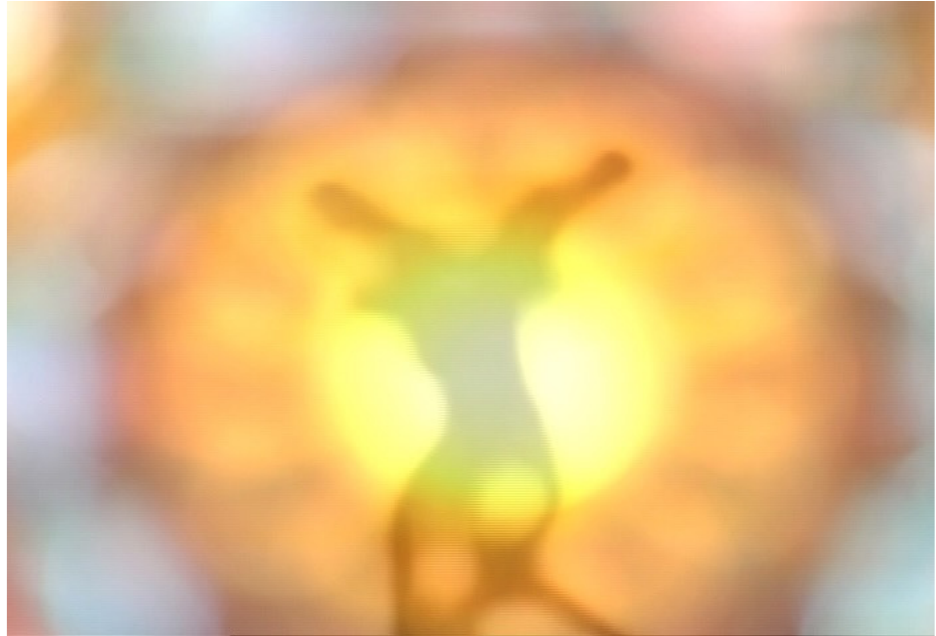
Figure 6. Baptism (2009). Digital film still. https://blackbird.vcu.edu/v9n1/gallery/ve-freeman_m/baptism-video.shtml (accessed on 26 September 2022).